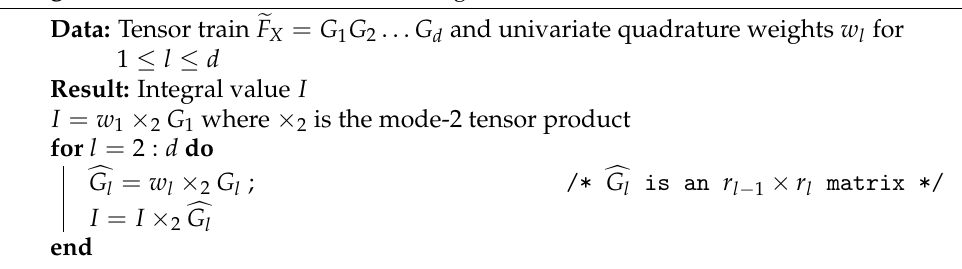
Algorithm 1: Tensor-Train Cubature